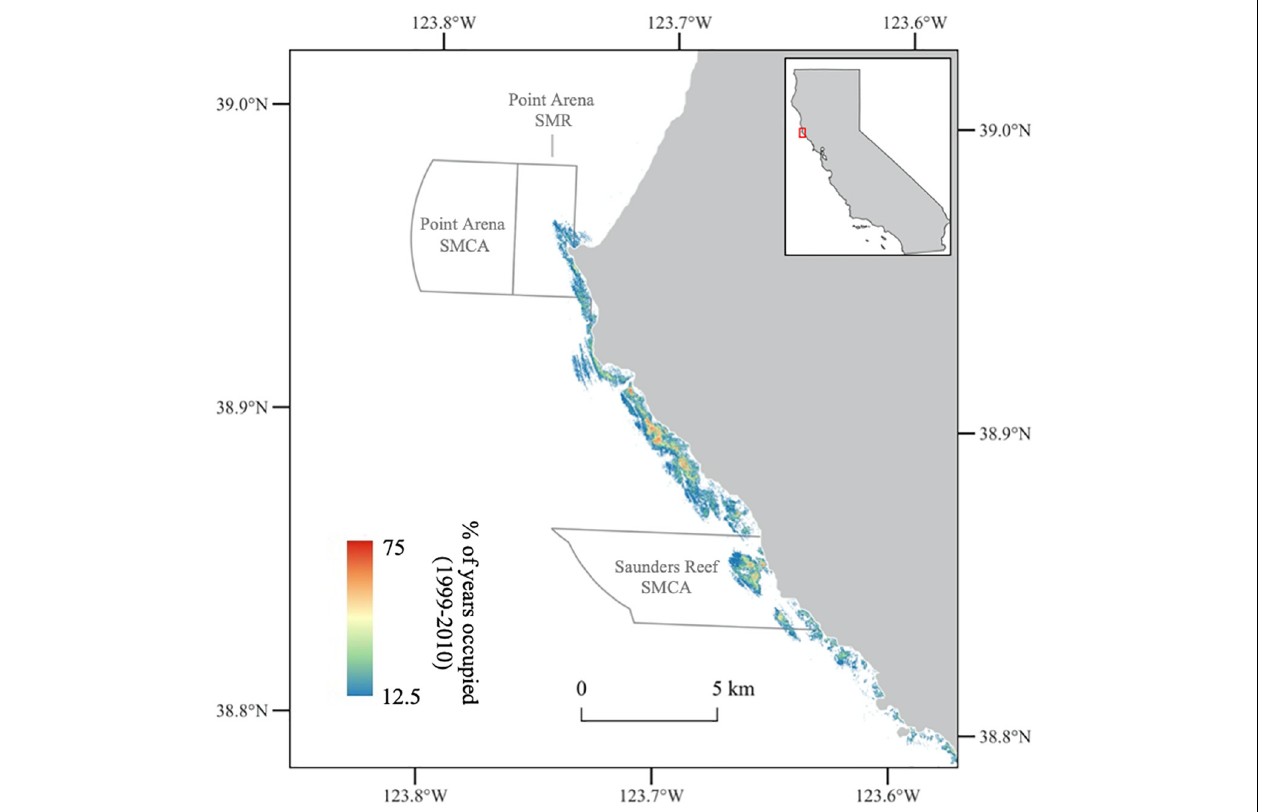
FIGURE 4 | Example kelp canopy persistence map created from the California Department of Fish and Wildlife annual aerial surveys. Persistence is calculated as the percentage of years between 1999 and 2010 with kelp canopy. State Marine Reserves (SMR) and State Marine Conservation Areas (SMCA) are outlined in gray. Kelp persistence data can be accessed from California Department of Fish and Wildlife at